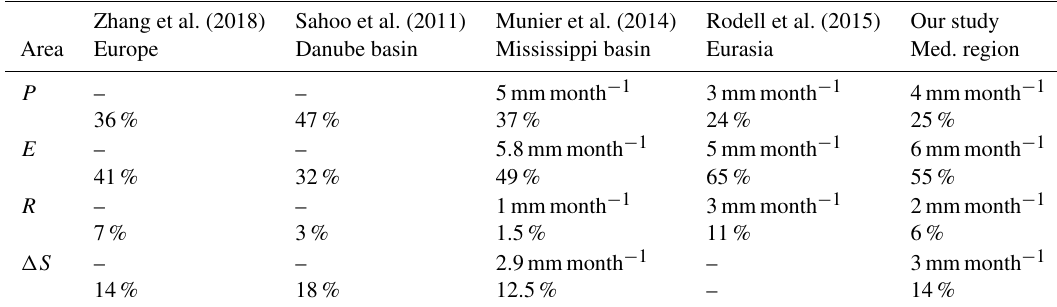
/ P σ 2 ) are expressed in i i